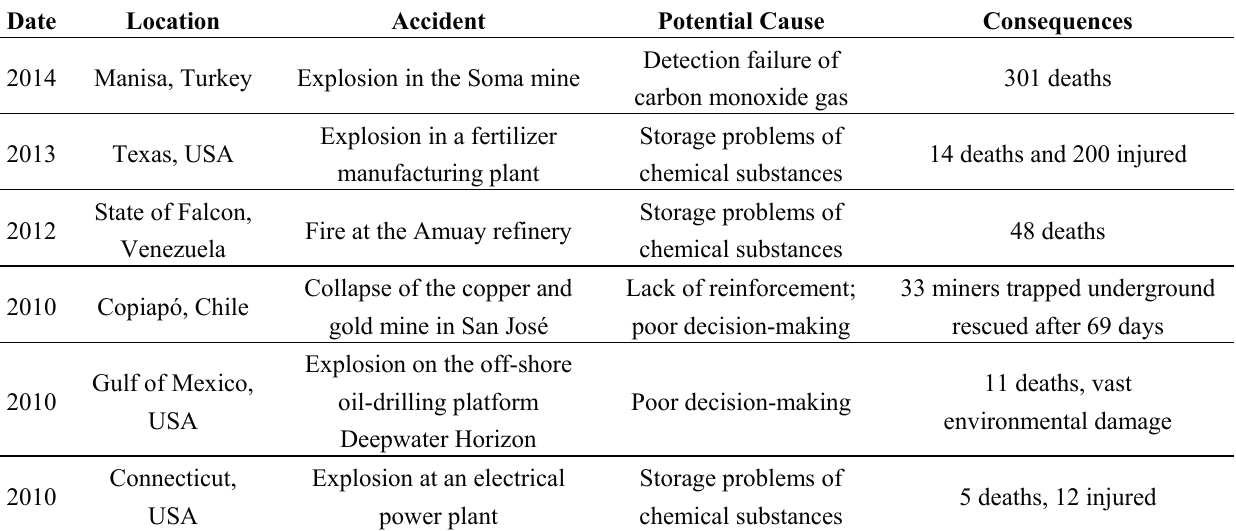
Table 1. Examples of major industrial